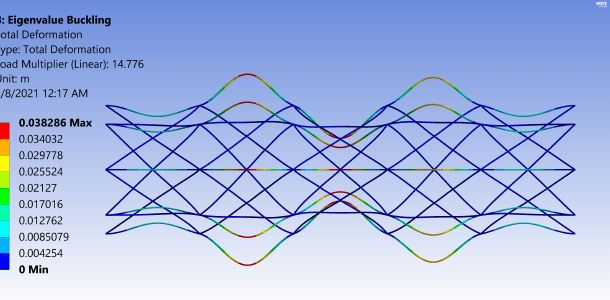
Figure 19. Local buckling of Set 2 OLC with thirteen carbon tows in helical members [26]. While the boundary constraint of Figure 18 acts similar to a pinned connection, the boundary constraint of Figure 19 approaches the behavior of a fixed connection. The ro- tation of the helical constraints at the nodes of the OLC are magnified for clarity in Figures 20 and 21.